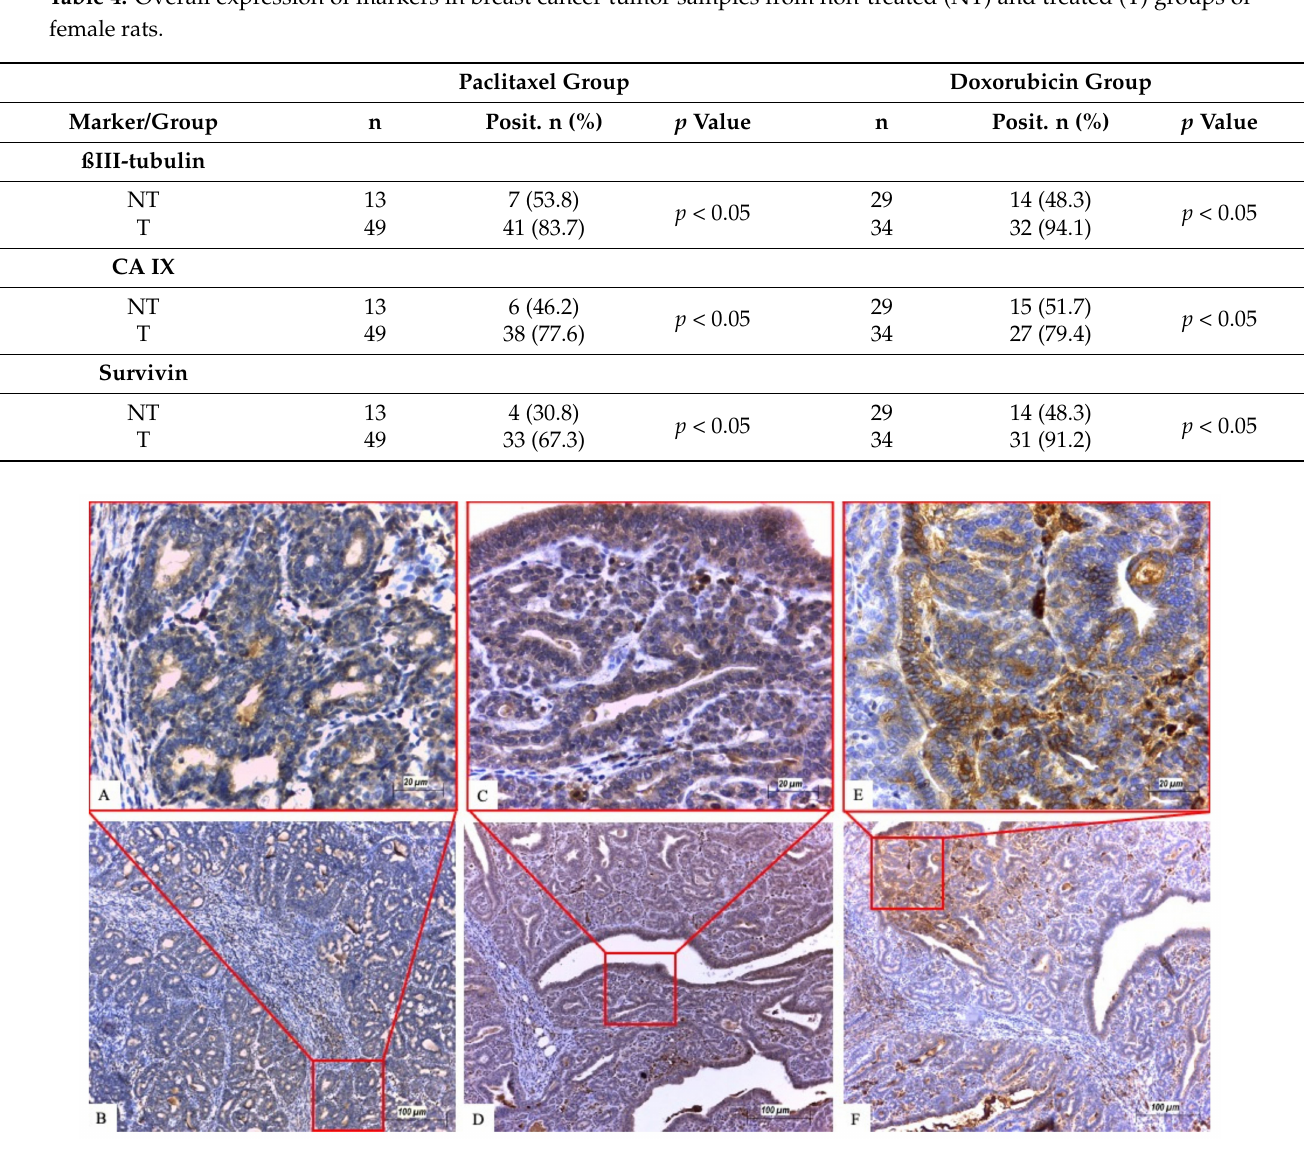
Figure 1. Immunohistochemical expression of proteins in invasive carcinoma. ( A , B ) ßIII-tubulin. ( C , D ) CA IX. ( E , F ) Survivin. Scale bars ( A , C , E ) 20 µ m; ( B , D , F ) 100 µ m. The upper images show the area with the red rectangle on lower images at higher